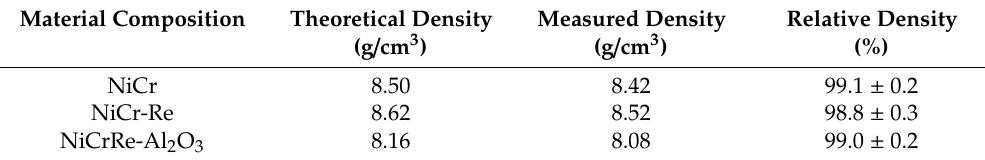
Figure 1. SEM and EDX micrographs of powders used for sintering process: ( a ) 100NiCr, ( b ) 99NiCr-1Re (green color refers to Re), ( c ) 90(99NiCr-1Re)-10Al 2 O 3 (yellow color refers to Re, and red-to Al 2 O 3 ). Table 1. Densities of the NiCr based materials sintered at 1050 ◦ C by SPS. Table 1. Densities of the NiCr based materials sintered at 1050 ° C by SPS.